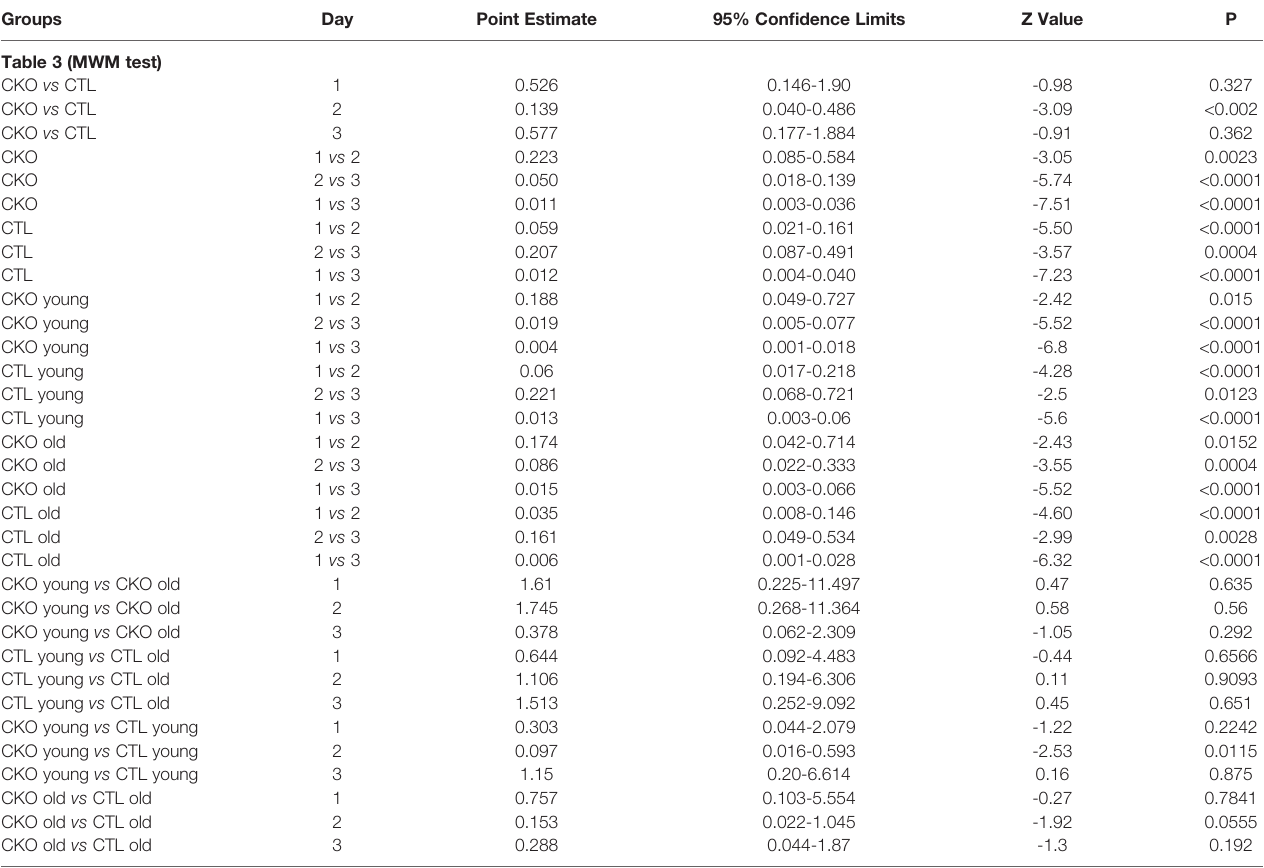
TABLE 3 | Multivariable Cox regression analysis for the MWM tests (time to platform) during the fi rst three days. Groups Day Point Estimate P Table 3 (MWM test) CKO vs CTL